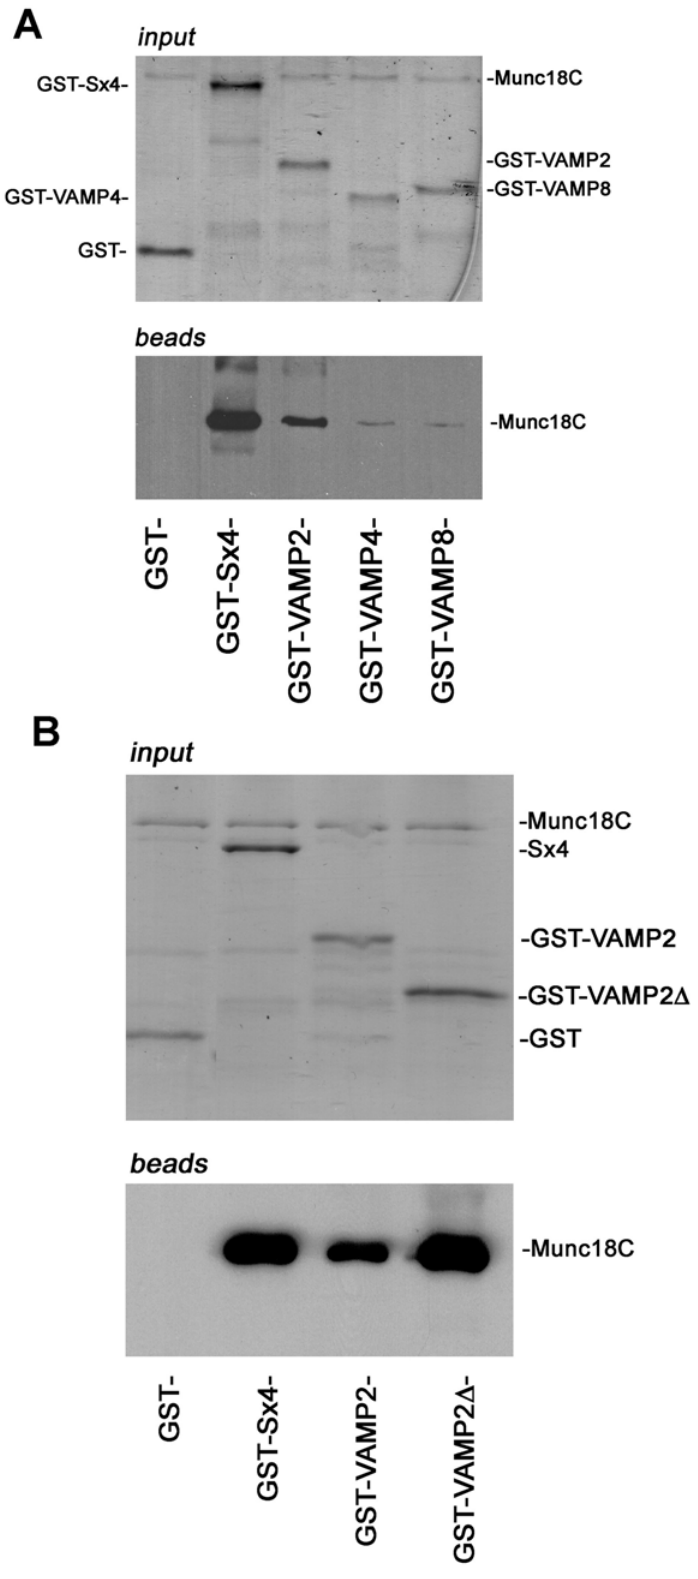
Figure 2. Munc18c binds directly to the cytosolic domains of Syntaxin 4 and VAMP2. (A) 5 m g of either GST, or GST fused to the cytosolic domain of Sx4, VAMP2, VAMP 4 or VAMP 8, immobilised on glutathione Sepharose were incubated overnight at 4 C with 5 m g His-tagged Munc18c in a volume of 500 m l. After extensive washing in binding buffer, SDS-PAGE and immunoblot analysis was used to determine which of the GST proteins Munc18c had bound to. Upper panel represents a Coomassie stained gel of input proteins; lower panel shows an immunoblot for bound Munc18c (B) The ability of Munc18c to bind to a version of GST-VAMP2 harbouring only the SNARE motif of the v-SNARE was assessed as in (A). Data are representative of four experiments of this type. doi:10.1371/journal.pone.0004074.g002 PLoS ONE |